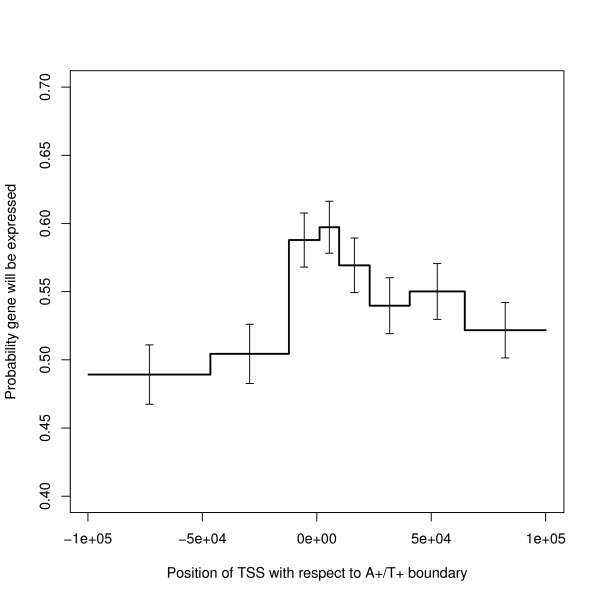
Probability of a gene being expressed by position of TSS with respect to the A+/T+ boundary. The bins have been defined by the quantiles of the distribution within the range plotted: in each bin, n ~ 1152. The error bars show 95% confidence limits. This shows a strong peak near the segment boundary and a long range asymmetry about the boundary.